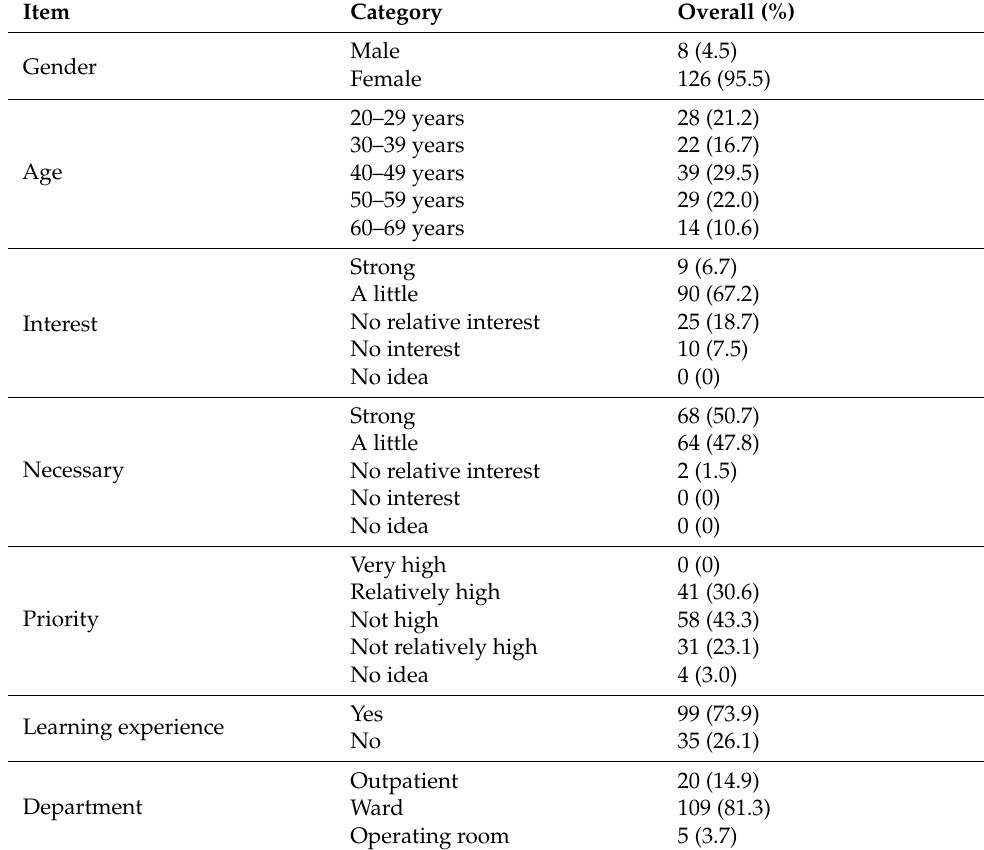
Table 2. Demographic data ( n =